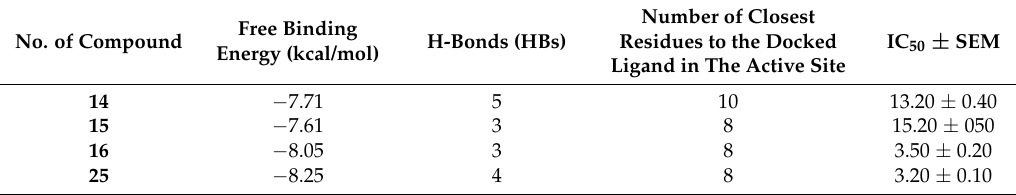
Table 2. IC 50 , docking binding energies, hydrogen bonding, and the number of closest residues to the docked ligands in the active site of the selected quinoxaline derivatives 14 , 15 , 16 , and 25 within the active binding site of thymidine